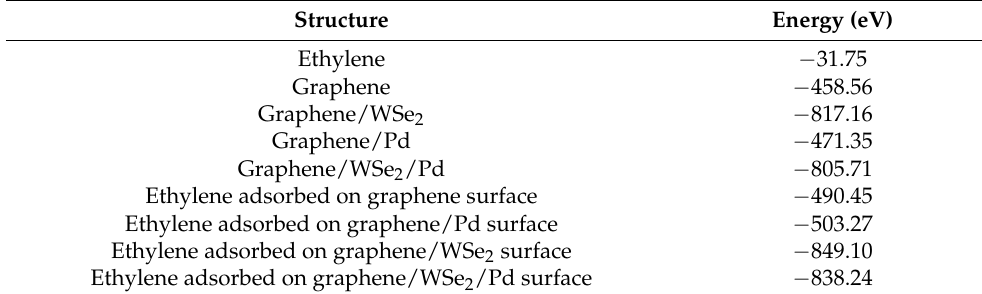
Figure 1. Optimized geometric models of ( a ) graphene and ( b ) graphene/WSe 2 , and adsorp- tion structures of ethylene molecules on ( c ) graphene, ( d ) graphene/Pd, ( e ) graphene/WSe 2 , and ( f ) graphene/WSe 2 /Pd. Table 1. The calculated single point energies of the adsorbed systems.